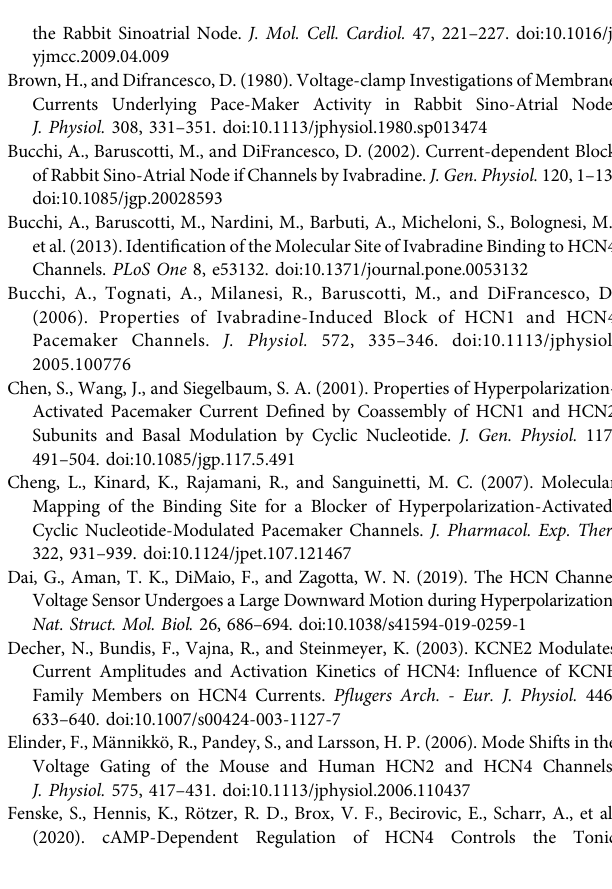
Supplementary Figure S1 | Sequence alignment of human and zebra fi sh HCN4 channels. The amino acid sequences were aligned using Clustal Omega (Sievers et al., 2011),and are shown using ESPript3 (Robert and Gouet, 2014).The S1toS6 segmentsandCNBDdomainfromhumanHCN4structure(PDB:6GYO)arelabeled above the alignments. The selective fi lter “ GYG motif ” is highlighted with an orange square. The residues involved in the cAMP binding and mutated in this study are highlighted with red dots. The red arrow indicates where the chimera constructs (4-4L and 4L-4 in Figure 2 ) are switched. Supplementary Figure S2 | Control MO or water injection do not affect heart rate. Averaged heart rates of uninjected, water-injected, and control MO-injected zebra fi sh embryos (52